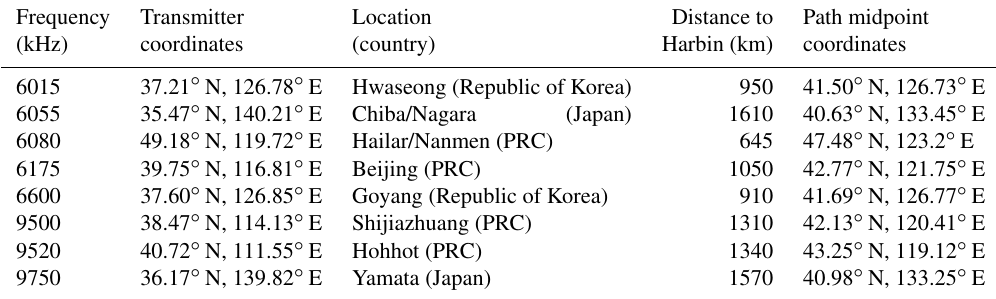
Table 3. Basic information on radio-wave paths. The data are retrieved from https://fmscan.org/index.php (last access: 17 March 2023). Frequency Transmitter Location Distance to Path midpoint (kHz) coordinates (country) Harbin (km) coordinates 6015 37.21 ◦ N, 126.78 ◦ E Hwaseong (Republic of Korea) 950 41.50 ◦ N, 126.73 ◦ E 6055 35.47 ◦ N, 140.21 ◦ E Chiba/Nagara (Japan) 49.18 ◦ N, 119.72 ◦ E Hailar/Nanmen